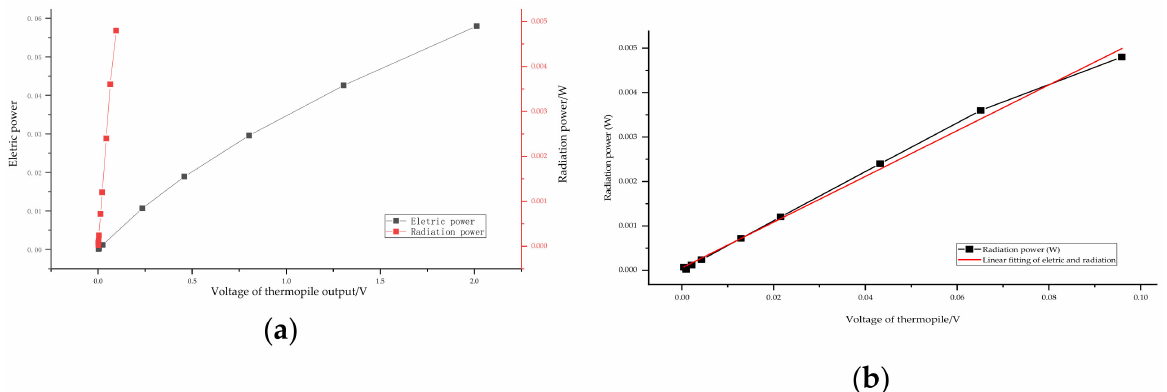
Figure 11. ( a )The relationship between infrared radiation power, heating resistance power and output voltage. ( b ) Linear fitting function of electric and radiation